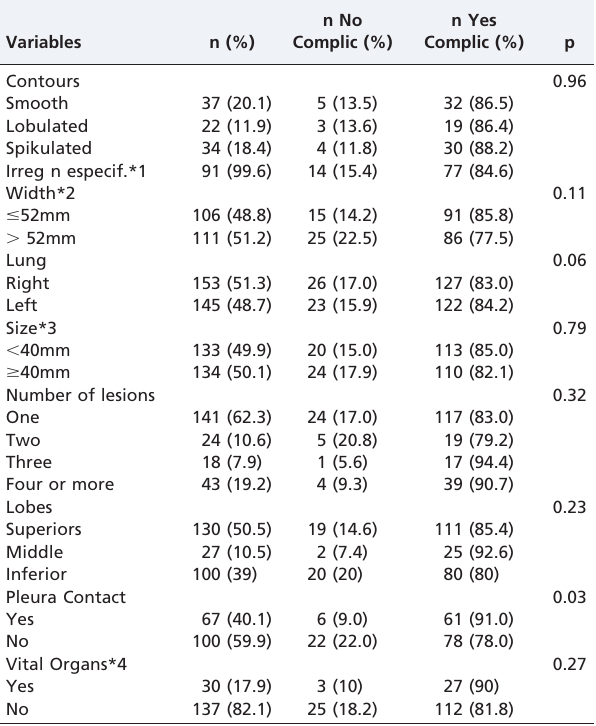
Table 3 - Analysis of lung lesions radiological characteristics and occurrence of complications in CT- guided FNAB of lung